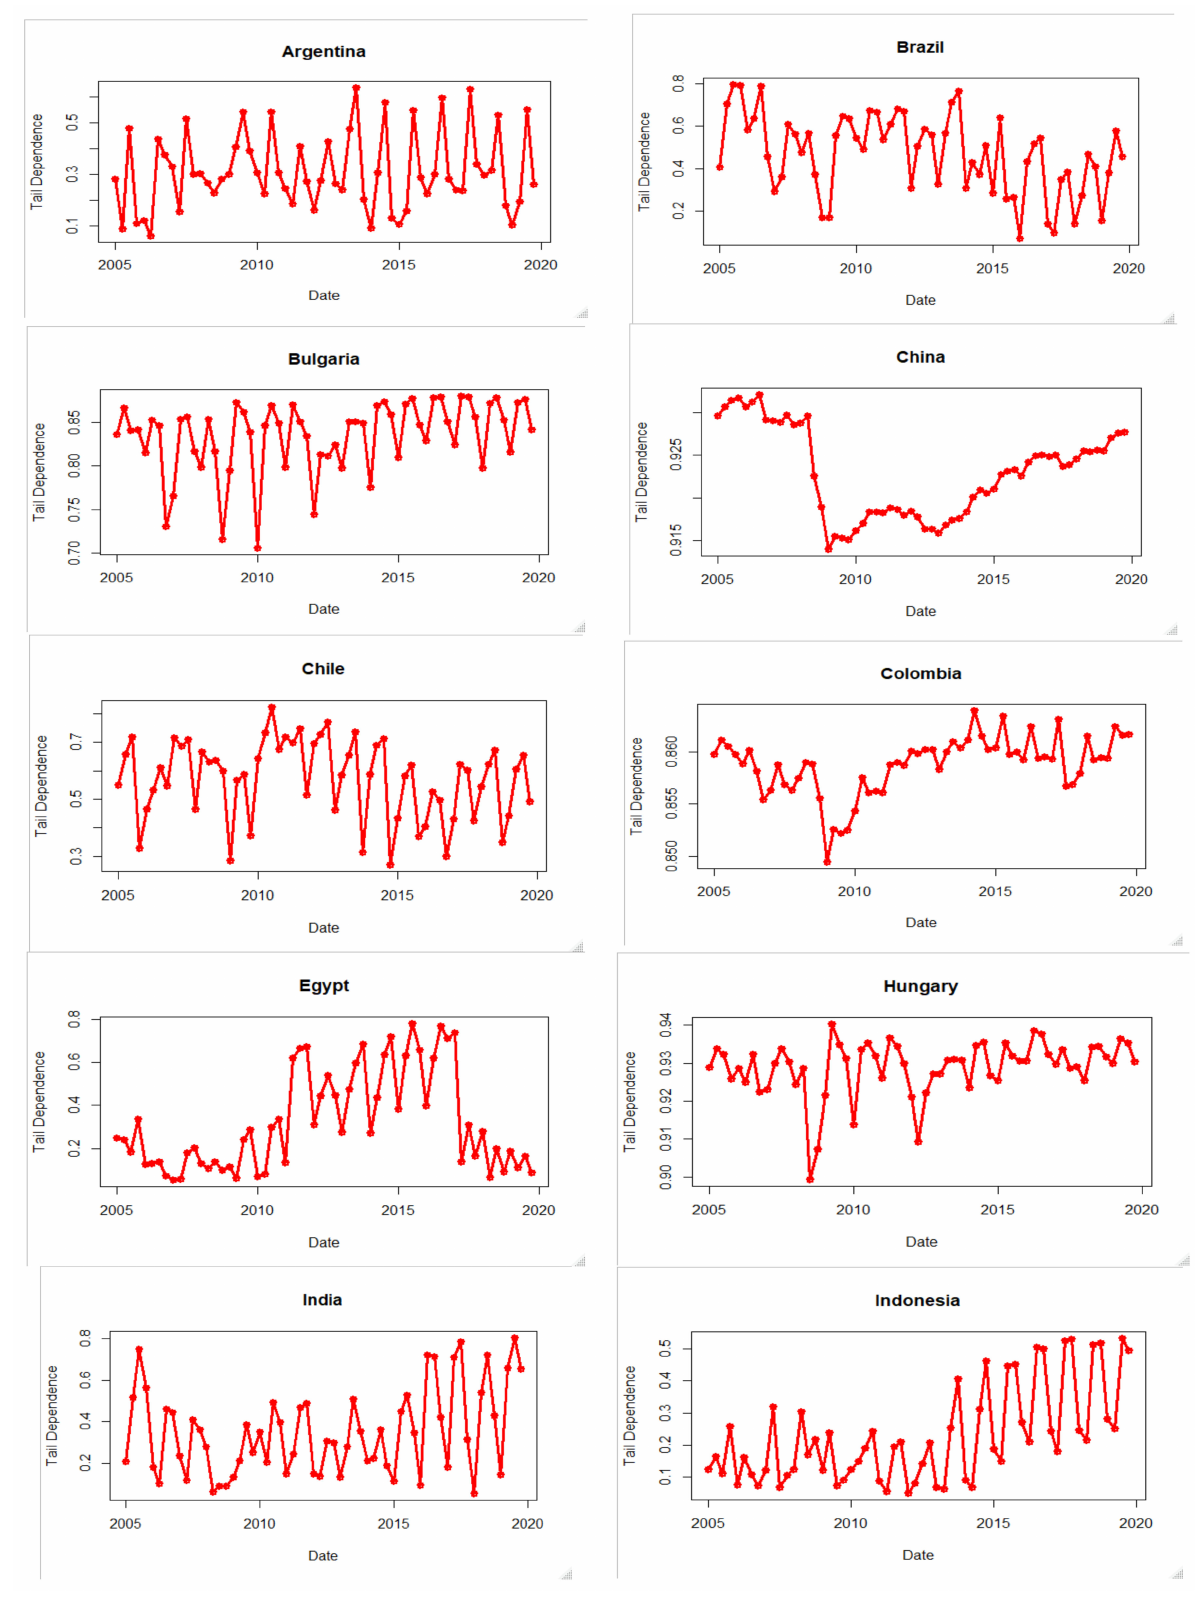
Figure 1. Time-varying tail dependence (contagion risk) between the U.S. economy and emerging countries: Argentina, Brazil, Bulgaria, China, Chile, Colombia, Egypt, Hungary, India, and